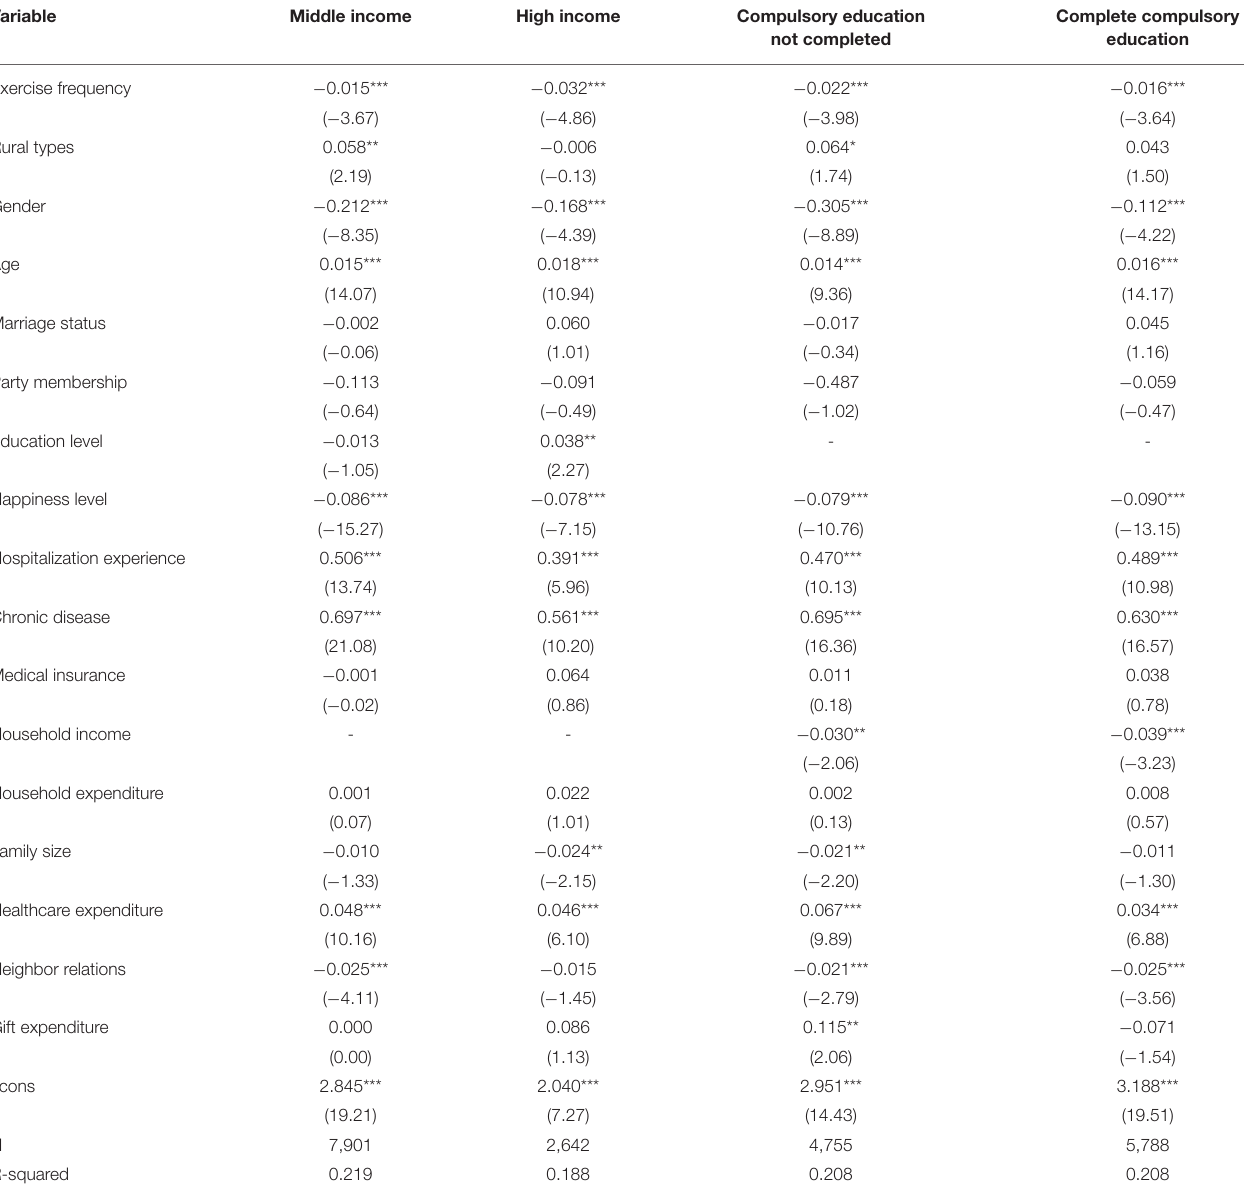
TABLE 7 | Heterogeneity test